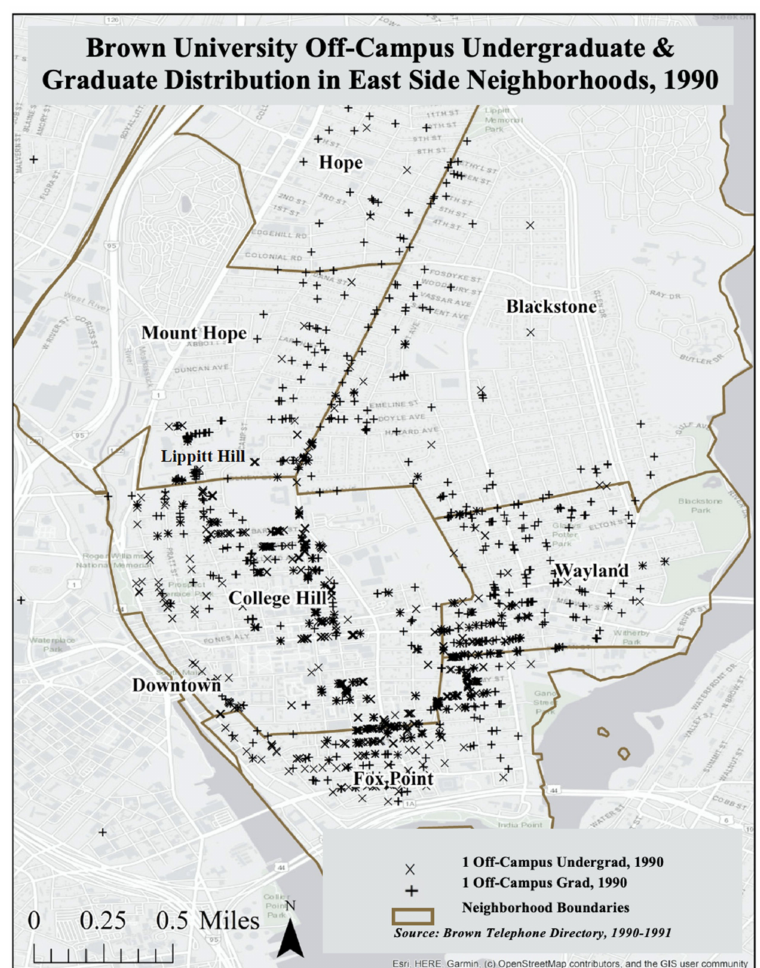
Figure 7. Brown University o ff -campus undergraduate and graduate distribution in East Side neighborhoods, 1990. In 1990, 1416 undergraduates lived at Providence o ff -campus addresses. This constituted 25% of the undergraduate population. The percent o ff -campus is inclusive of all undergraduates with a Providence address (including some in neighborhoods beyond the East Side) and calculated using historical enrollment data; 973 graduate students lived at Providence o ff -campus